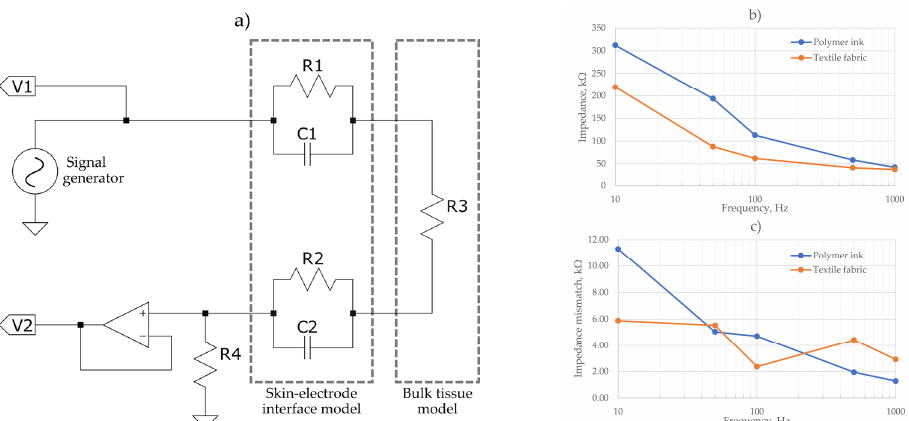
Figure 5. ( a ) Skin-electrode interface and tissue model for impedance measurement setup, ( b ) Measured impedance of the skin electrode interface, ( c ) impedance mismatch between electrode pairs.